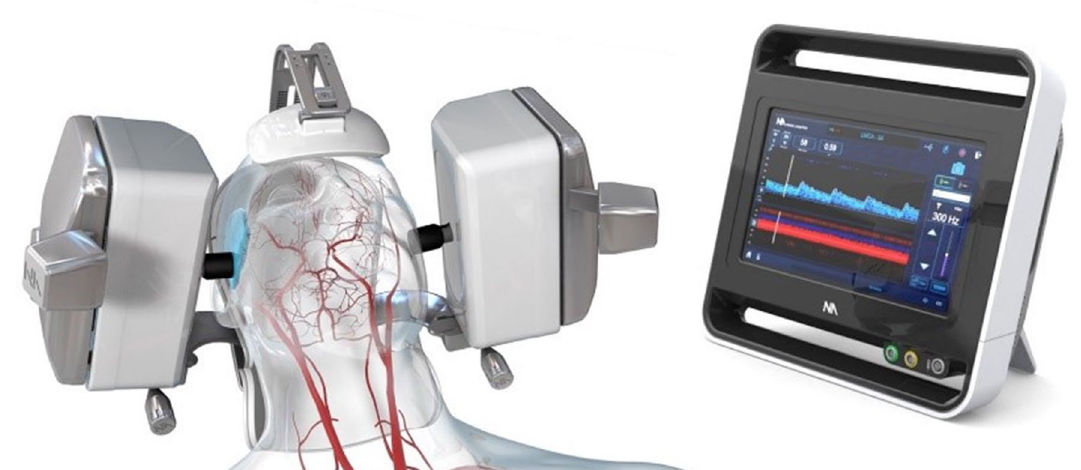
Figure 1. NovaGuide system—five degree of freedom robotic TCD system. [Original image created by manuscript author Dr. Robert Hamilton of